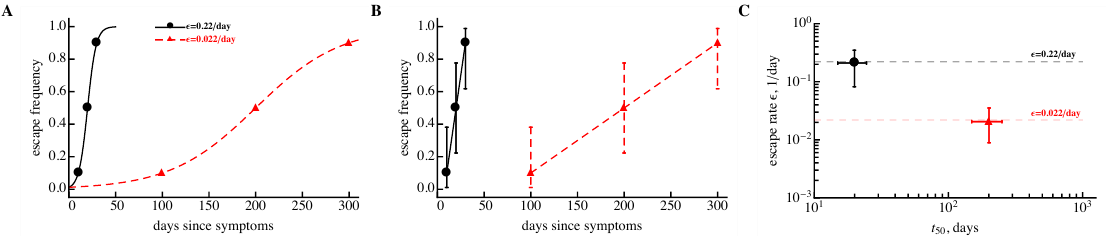
Figure 1. A sampling method accurately recovers virus escape rate for data when both wild-type and escape variant are detected at multiple sequential time points. We simulated viral escape using a logistic equation with two escape rates: ε = 0.22/day (bullets) and ε = 0.022/day (triangles). Three data points at which the escape variant was present at 10%, 50%, and 90% out of N = 10 sequences were generated (panel A ). These simulated data were fitted by the simple logistic model (Equation (1)) using a likelihood approach, leading to expected escape rates (lines in panel A). These data were then resampled using the beta distribution (panel B , black solid line is for ε = 0.22/day and red dashed line is for ε = 0.022/day) and fitted by the same model using the likelihood method. Resulting averages and their 95% confidence intervals match well with the numbers estimated using actual data (panel C ). Dashed lines in panel ( C ) show estimates of the escape rates found in panel ( A ), and 95% confidence intervals in panel ( B ) are predicted using Jeffrey’s intervals